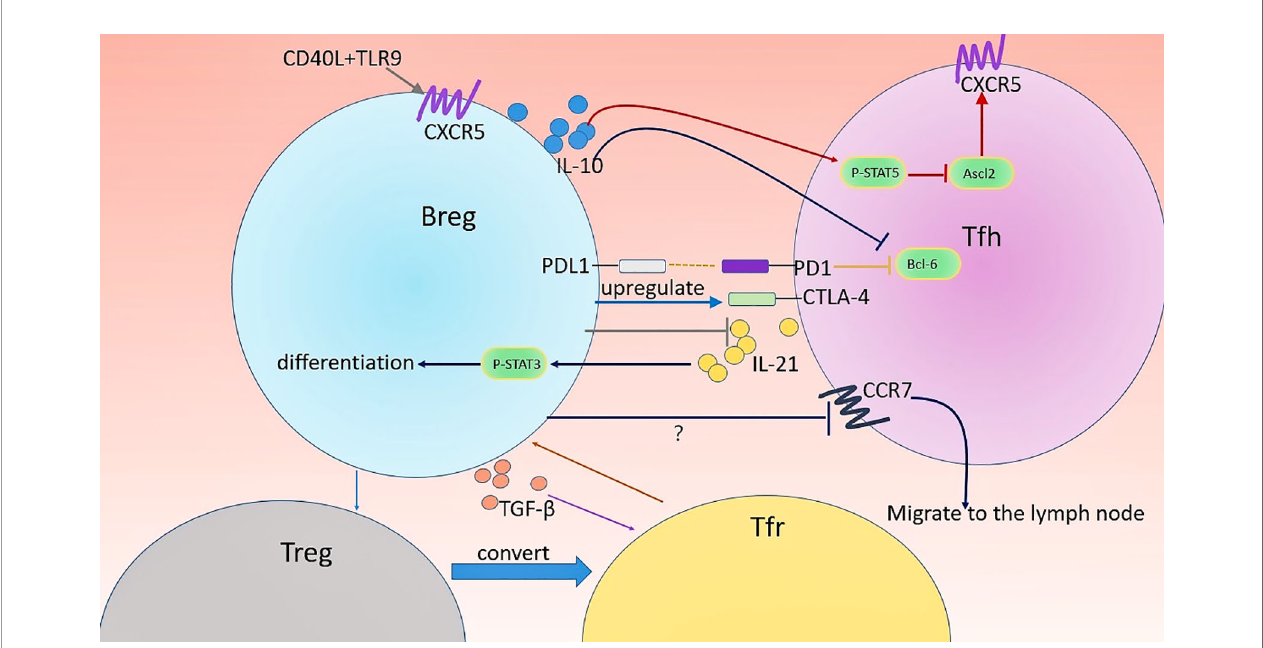
FIGURE 2 | Regulation of Tfh and Tfr cells by Bregs. Several types of Breg are involved in the regulation of the differentiation, function, and distribution of Tfh and Tfr cells. Firstly, CD40 and TLR9 might favor the migration of CD19 hi IgD + CD38 hi CD24 hi CD40 hi PD-L1 + IL-21R + human Bregs into GC by promoting CXCR5 expression. CD19 + CD1d hi CD5 + Bregs-derived IL-10 downregulates the expression of CXCR5 in Tfh cells by inhibiting Ascl2, the positive regulator of CXCR5, leading to impaired maturation and Il-21 production of Tfh cell. Moreover, MZB cells play a crucial role in the maintenance of CTLA-4 in Tfh cells. The location of Tfh cells can affect their function. IL-10 + MZP B cells direct this migration of Tfh cells out of follicles possibly through altering the expression of CCR7 (crucial chemokine receptors required for the localization of T cells in the LN) in Tfh cells. In turn, Tfh cell activates p-STAT3 in an IL-21-depadent manner therethrough driving the differentiation of CD19 + CD5 + CD1d hi Bregs. CD19 hi IgD + CD38 hi CD24 hi CD40 hi PD-L1 + IL-21R + human Bregs can promote Tfr cell differentiation and TGF- b play an important role in this process. Possibly, these Bregs induce Treg through IL-10 production and thereby increase Treg conversion into Tfr